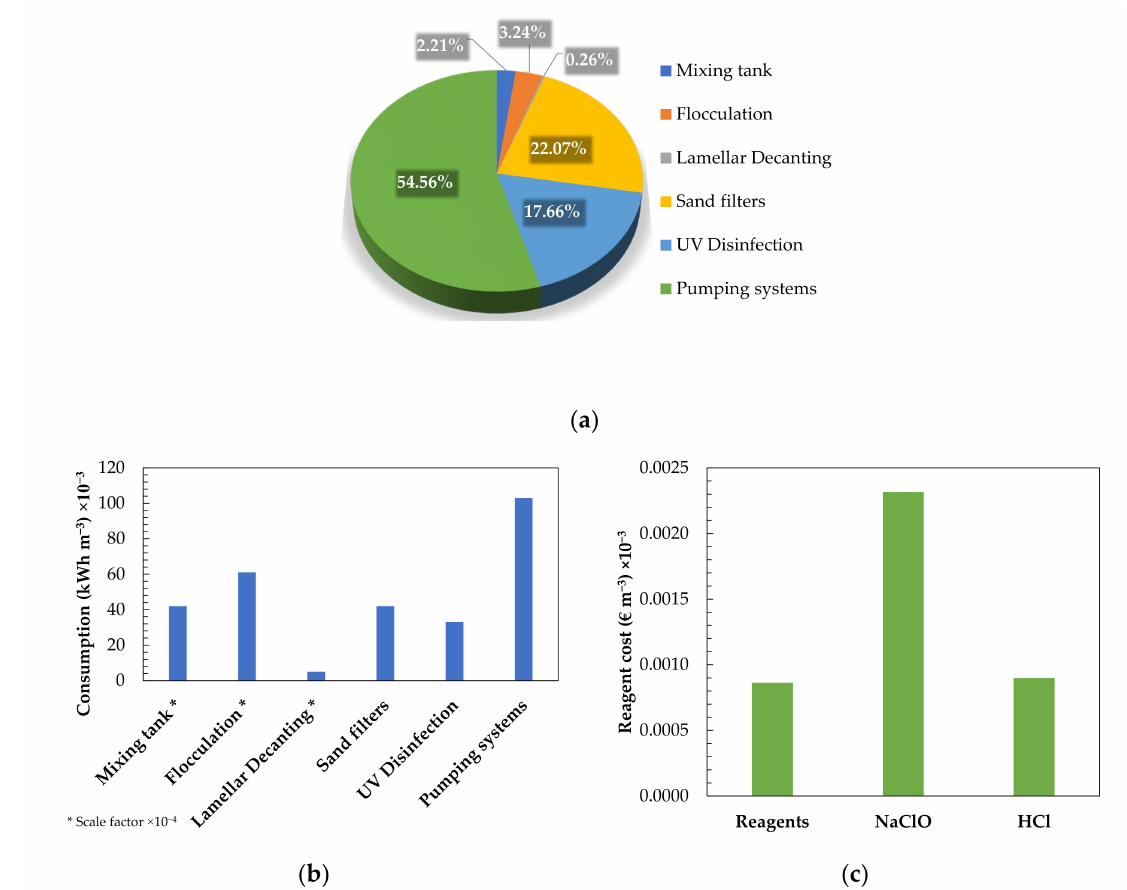
Figure 6. Electrical consumption and cost of the chemical reagents used in the conventional tertiary treatment of the Galindo WWTP: ( a ) estimated percentage of the total energy consumption related to each process of the tertiary treatment; ( b ) energy consumption of each process involved in the tertiary treatment; and ( c ) cost relative to the reagents used in the oxidation and coagulation–flocculation